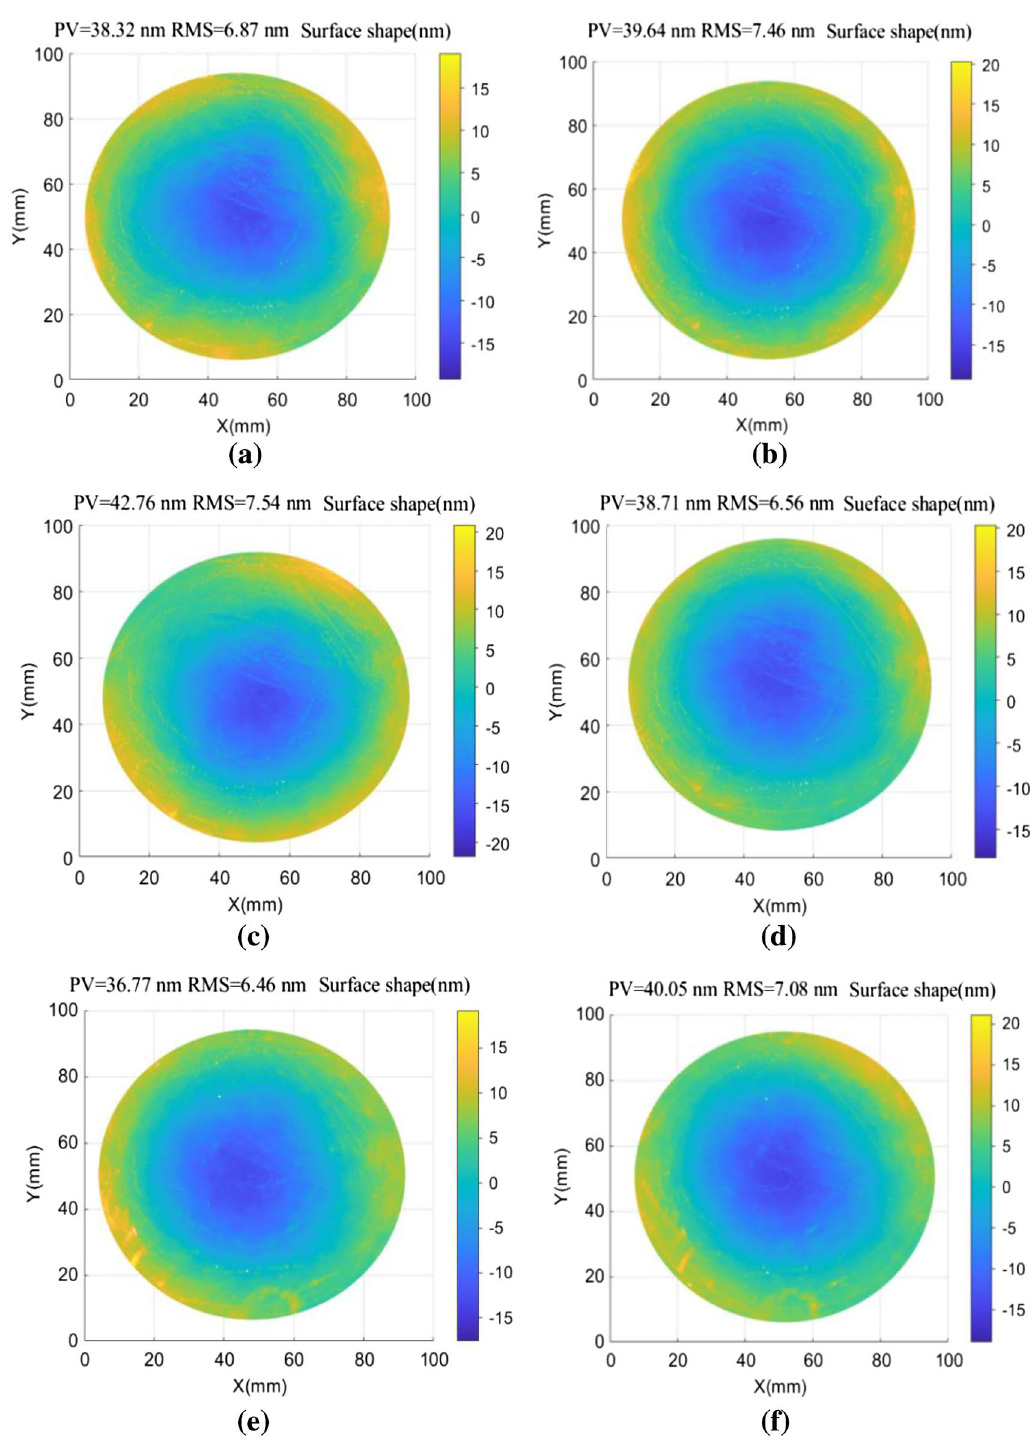
Figure 5. An interference wavefront diagram showing the resulting interference in various directions and at specific positions, including: ( a ) s 1 = 4 mm in the − x direction, ( b ) s 1 = 4 mm in the + x direction, ( c ) s 1 = 4 mm in the − y direction, ( d ) s 1 = 4 mm in the + y direction, ( e ) s 2 = 4.3 mm in the − x direction, ( f ) s 2 = 4.3 mm in the + x direction, ( g )